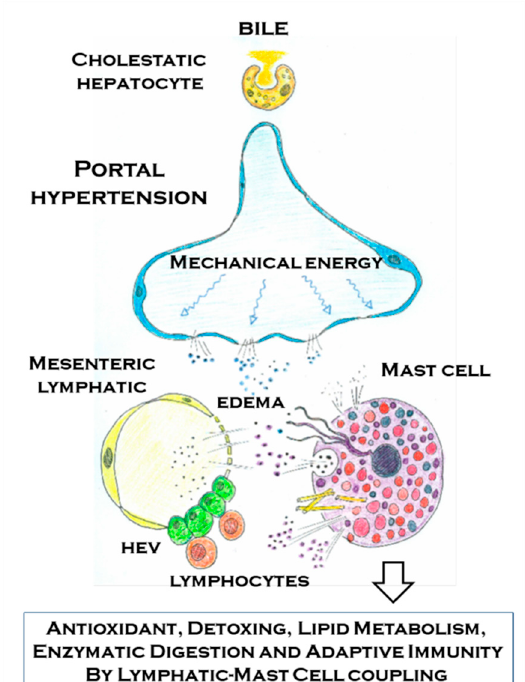
Figure 6. Schematic representation of the relationship that is established in portal hypertension associated with cholestatic chronic liver diseases between the mesenteric venous portal and lymphatic endothelium with the mast cell. The sensor ability of the mast cells to chemical (damage associated molecular pattern and pathogen associated molecular pattern) and physical (mechanical energy) stimuli allows it to selectively react by means of its multiple mechanisms to the abovementioned stimulus in portal hypertension. The mast cells mechanisms of action include degranulation, exosomes / extracellular vesicles, tunneling nanotubes, extracellular trap formation and mast cells migration to the mesenteric lymph nodes, where they reach the high endothelial venules (HEVs), and then they would activate the adaptive immunity. The mast cells through these mechanisms would try to antagonize some of the impairments that are typical of portal hypertension associated with chronic liver disease. Between the protecting functions of the mast cells and their ability to antagonize the oxidative stress, the toxic intestinal substances and the immunologic injury stand out.